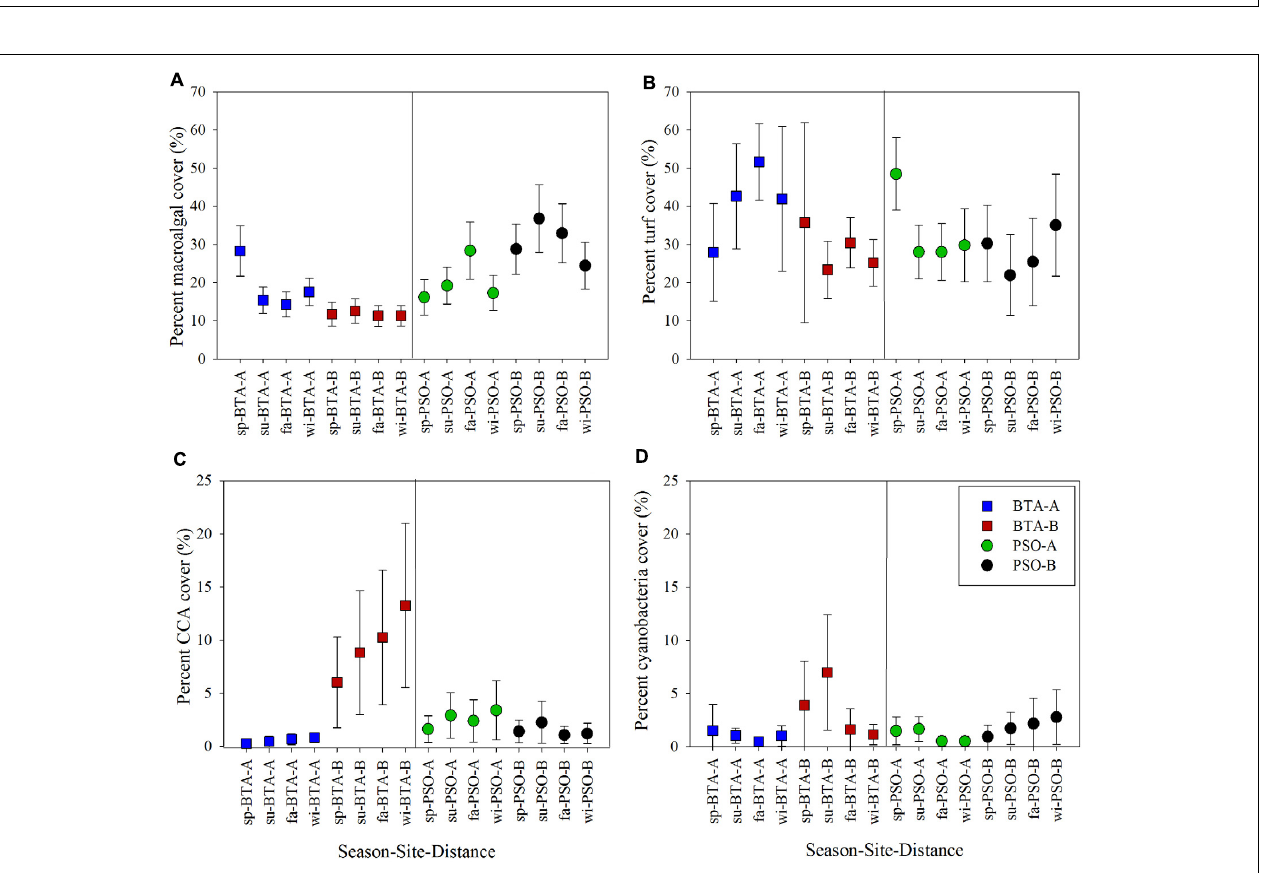
FIGURE 8 | Percent species composition of Scleractinian and hydrocoral species. Most dominant species among site, distance zone and seasons identified by colors. Seasons are defined as: sp, spring; su, summer; fa, fall; wi, winter.